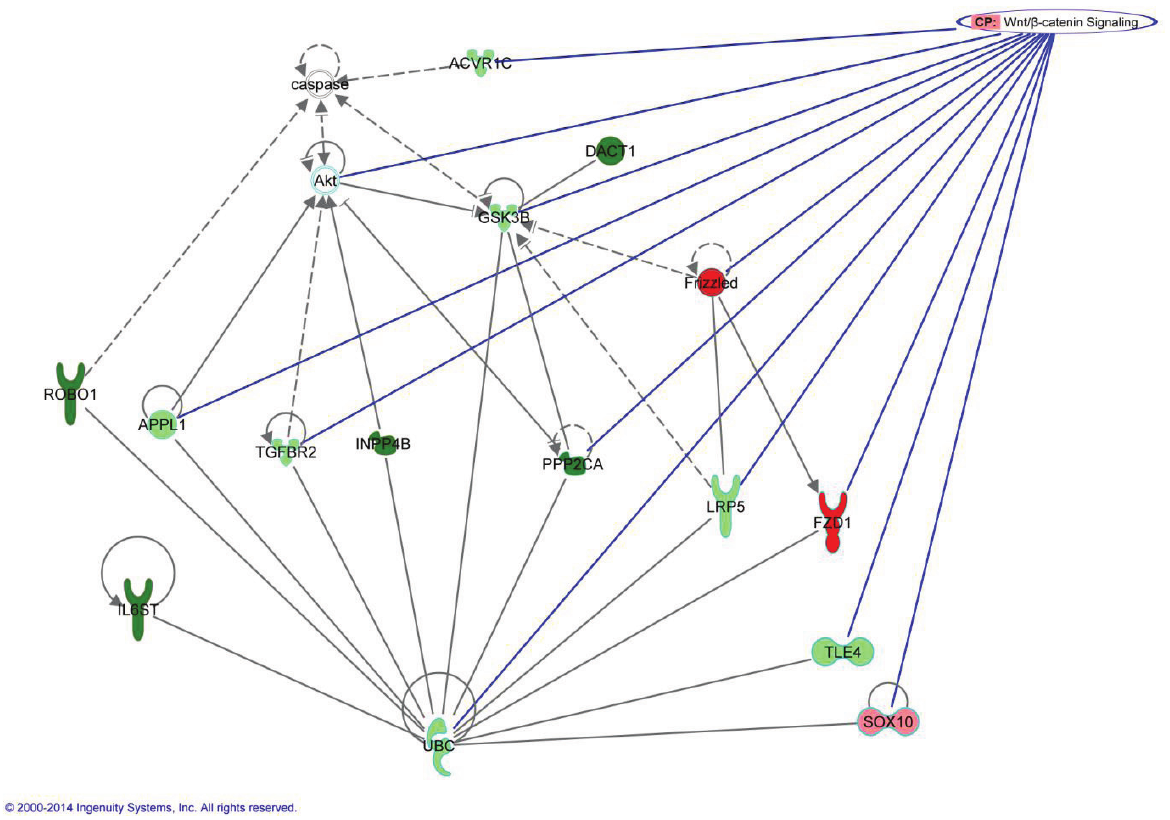
Figure 4. Interaction of target genes in Wnt/β -catenin signaling. The green genes are statistically parous hypermethylated, while the ones colored red are statistically nulliparous hypermethylated. The darker genes have recorded DMRs, and this is to the exception of GSK3B, which was first found statistically significant hypermethylated in the parous breast, but its DMR is hypermethylated in the nulliparous samples. This network was generated through the use of IPA (Ingenuity ® Systems)